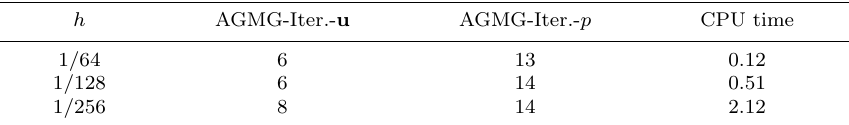
Table 4. Number of iterations for computing ( u n +1 ,p n +1 ) in Algorithm 3.